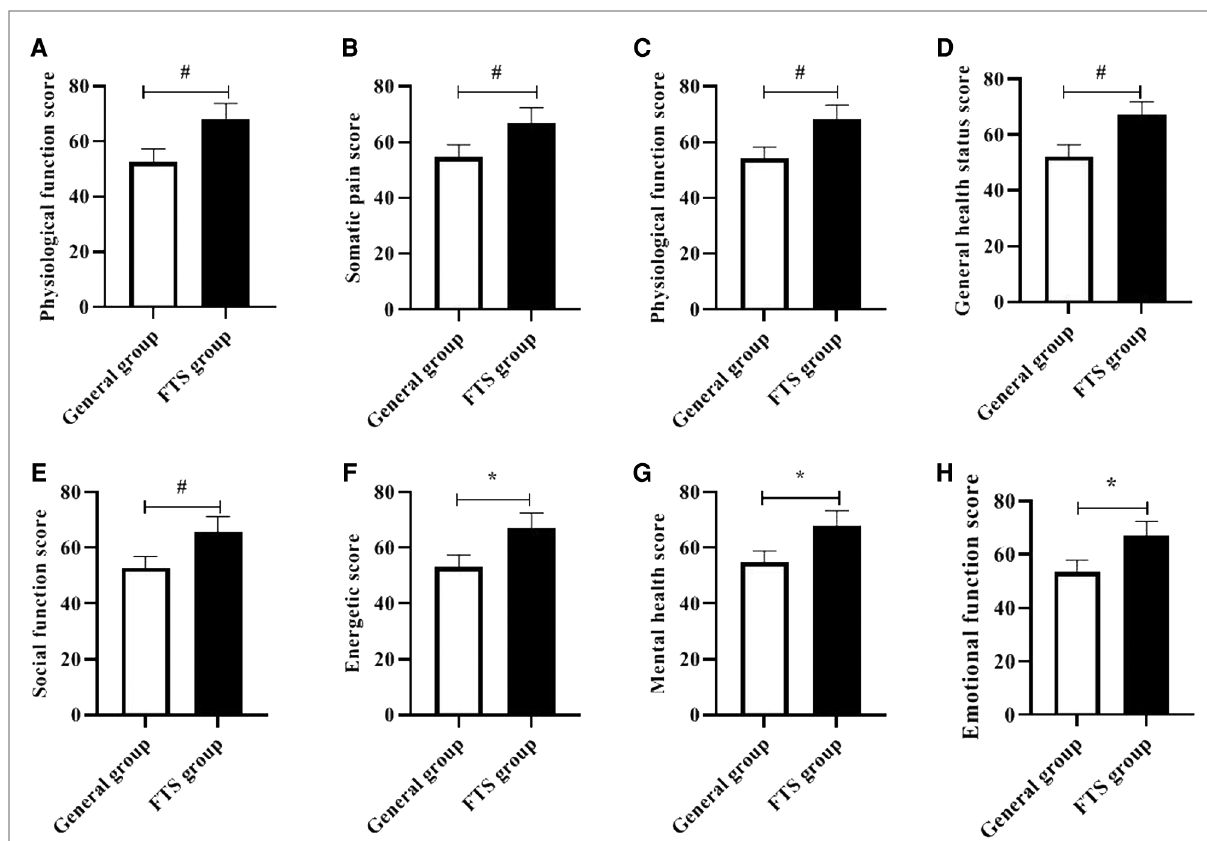
FIGURE 3 Comparison of short-term quality of life between the two groups. #,* Indicates P <0.05 compared with the general group. Figure ( A-H ) shows the comparison of physical function, somatic pain, physiological function, general health status, social function, energy, mental health, and emotional function scores between the two groups, respectively.